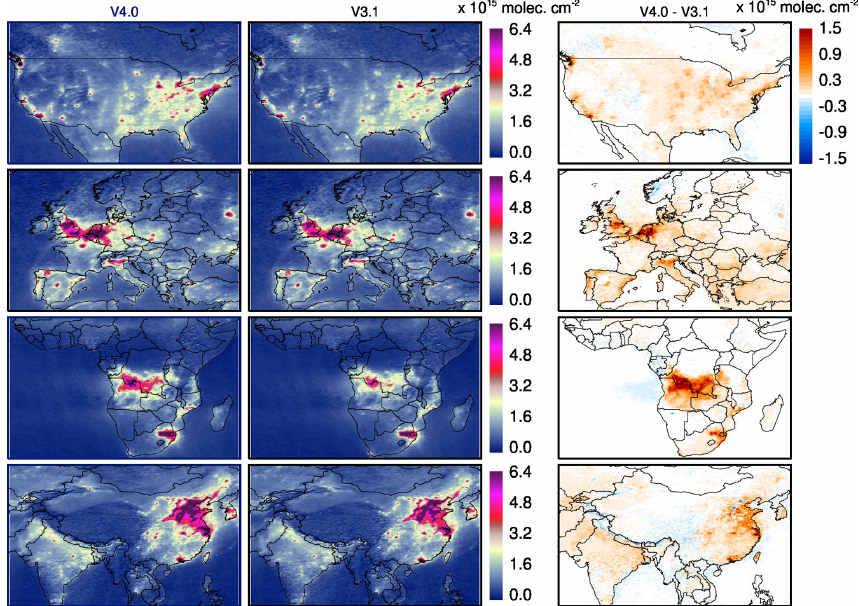
Figure 9. The 3-month (June, July, August) average tropospheric NO 2 columns for low cloud conditions (CRF < 0.5) in 2005 over North America (first row), Europe (second row), southern Africa (third row), and Asia (fourth row) from V4.0 (first column), V3.1 (second column), and their difference